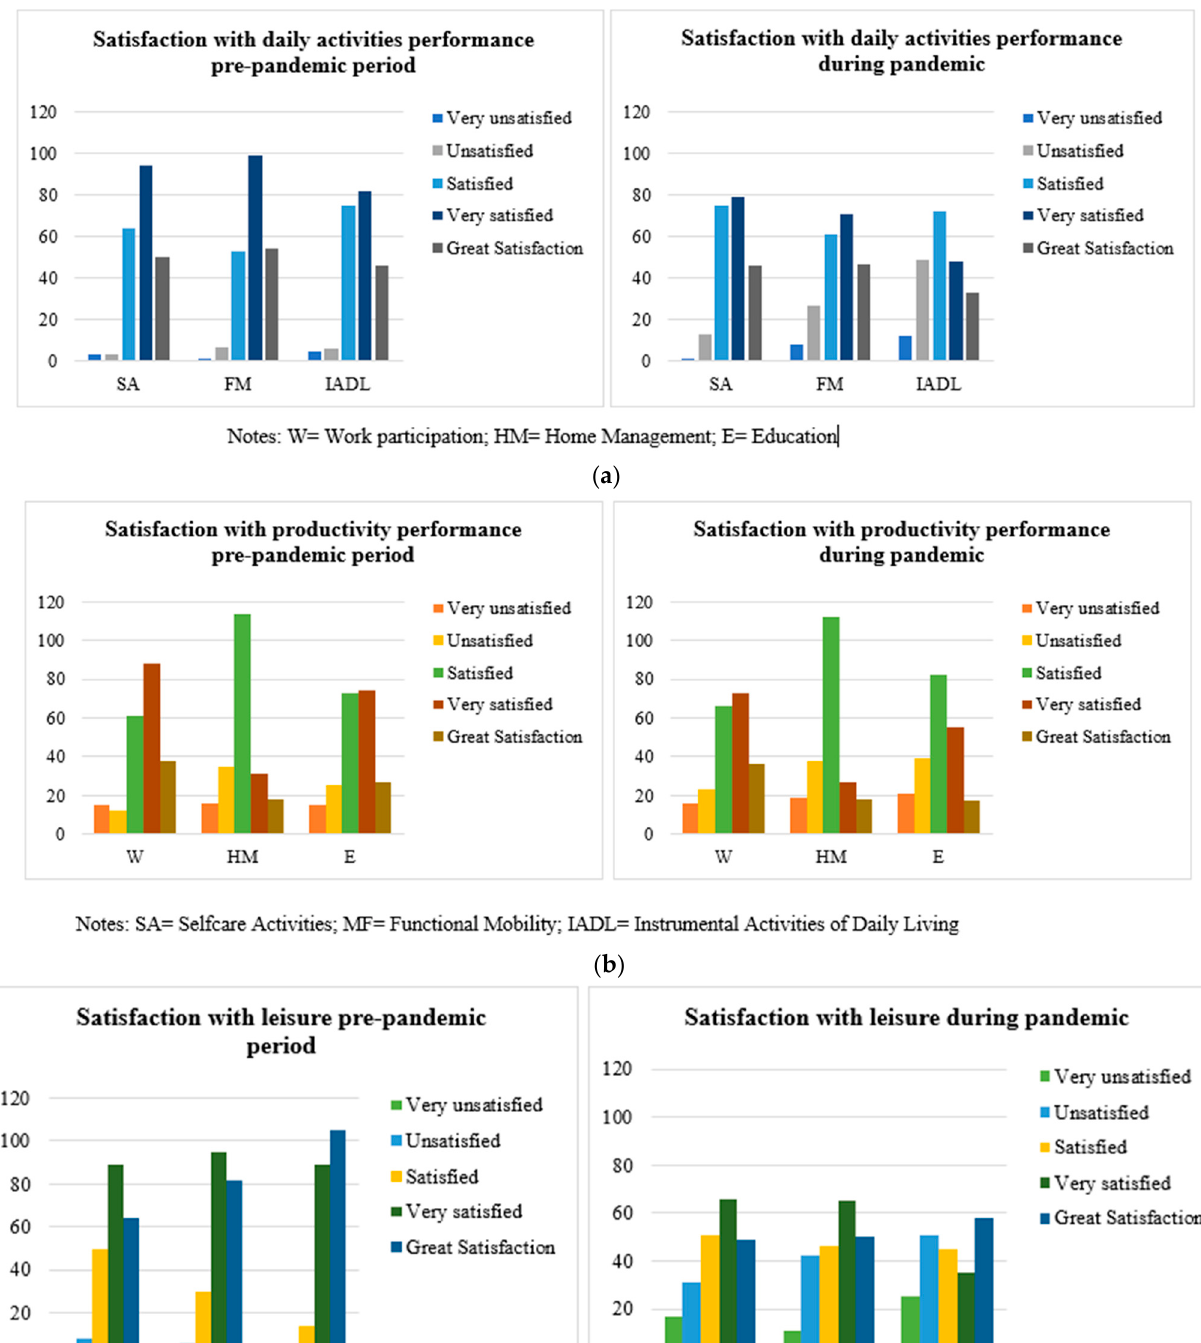
formance. ( c ) Satisfaction with leisure. mance. ( c ) Satisfaction with